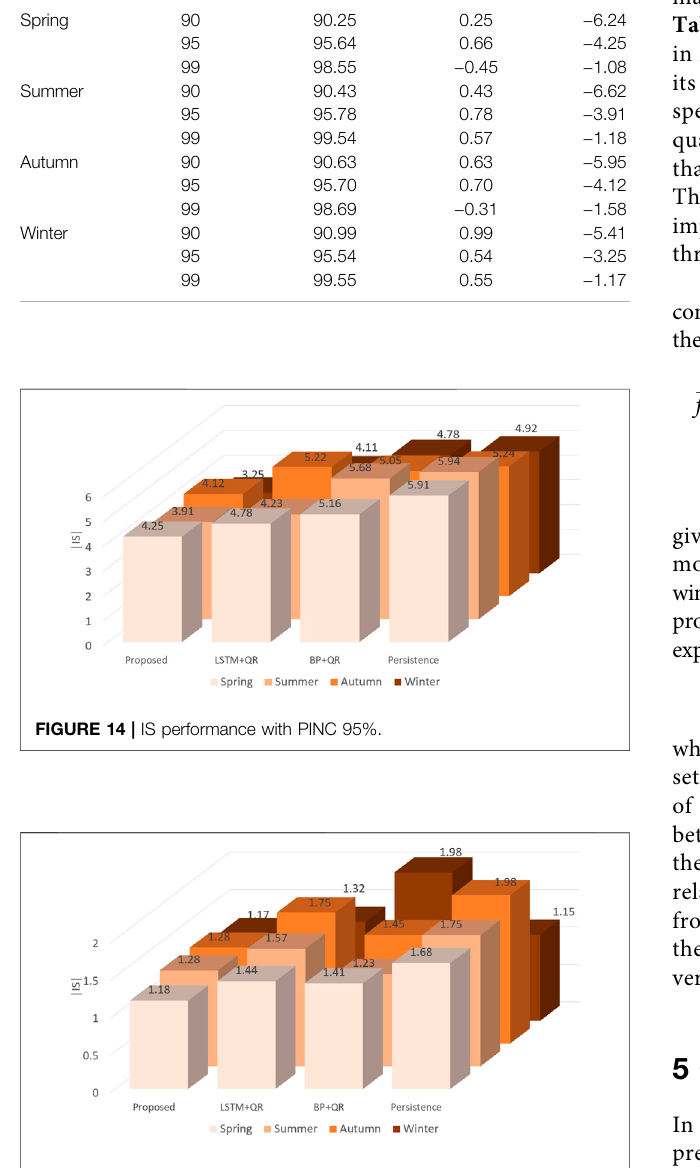
FIGURE 15 | IS performance with PINC 99%.